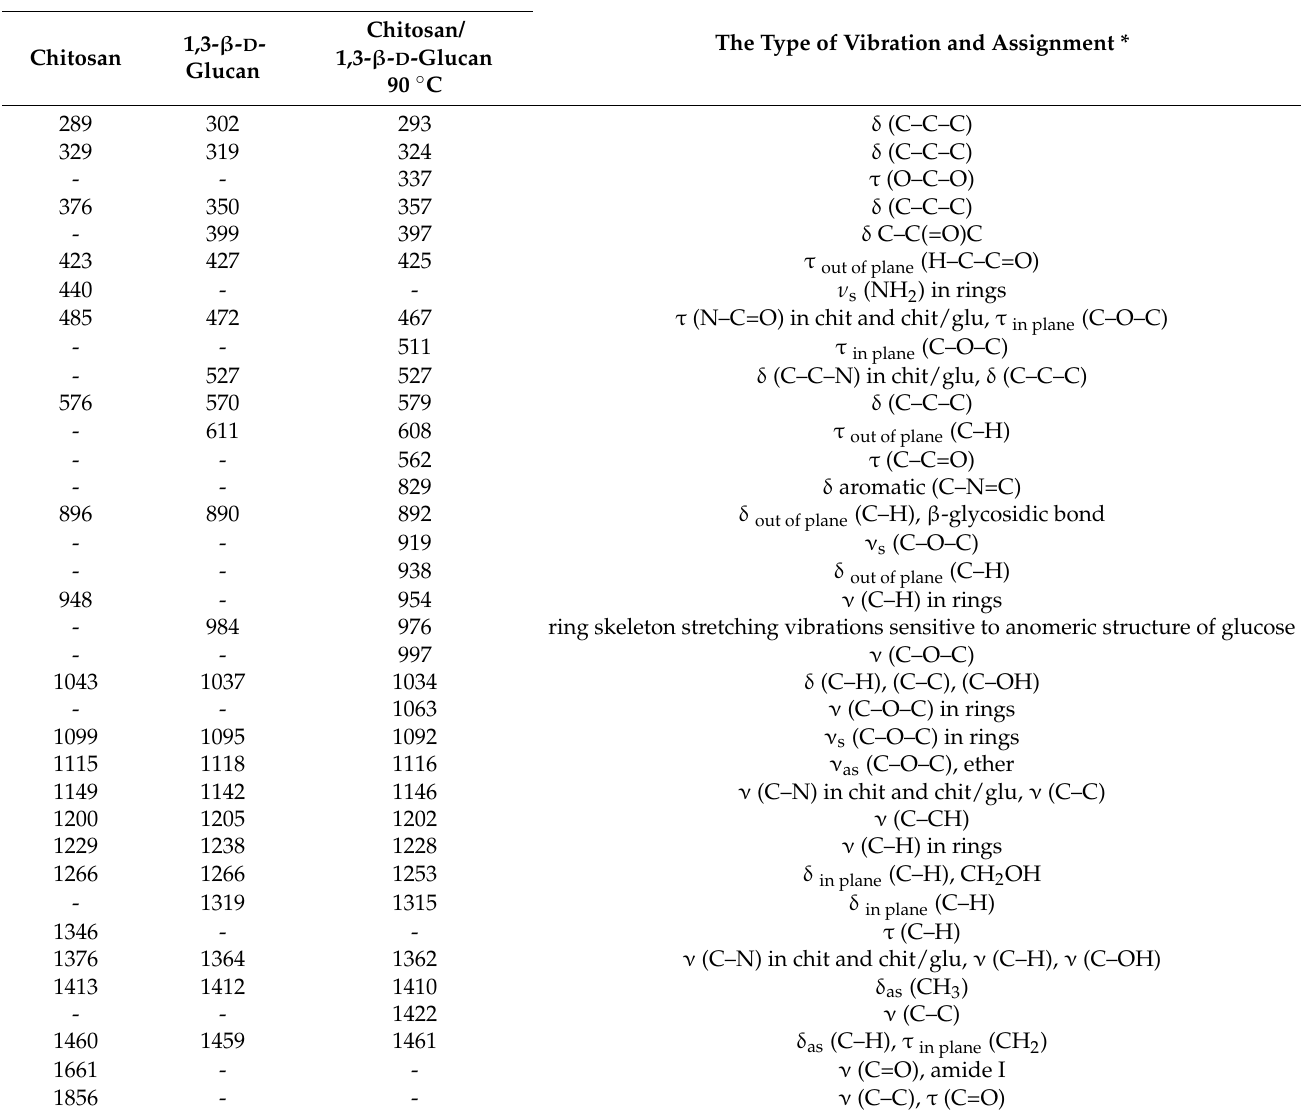
Table 2. The most prominent bands detected in the Raman spectra of chitosan, 1,3- β - D -glucan, and chitosan/1,3- β - D -glucan films cross-linked at 90 ◦ C.